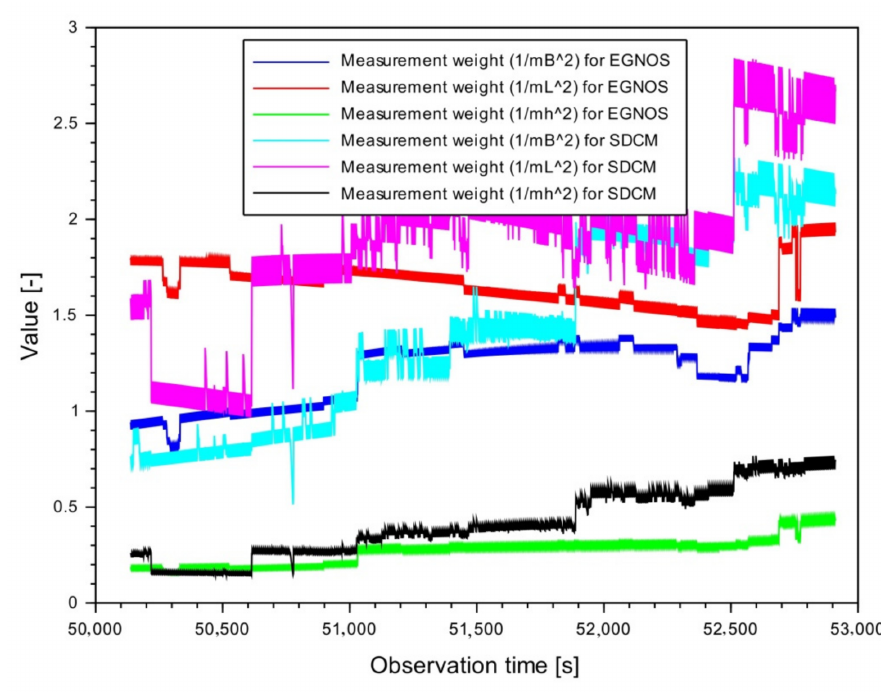
Figure 5. The measurement weights are a function of the inverse square of mean errors (see Algo- rithms